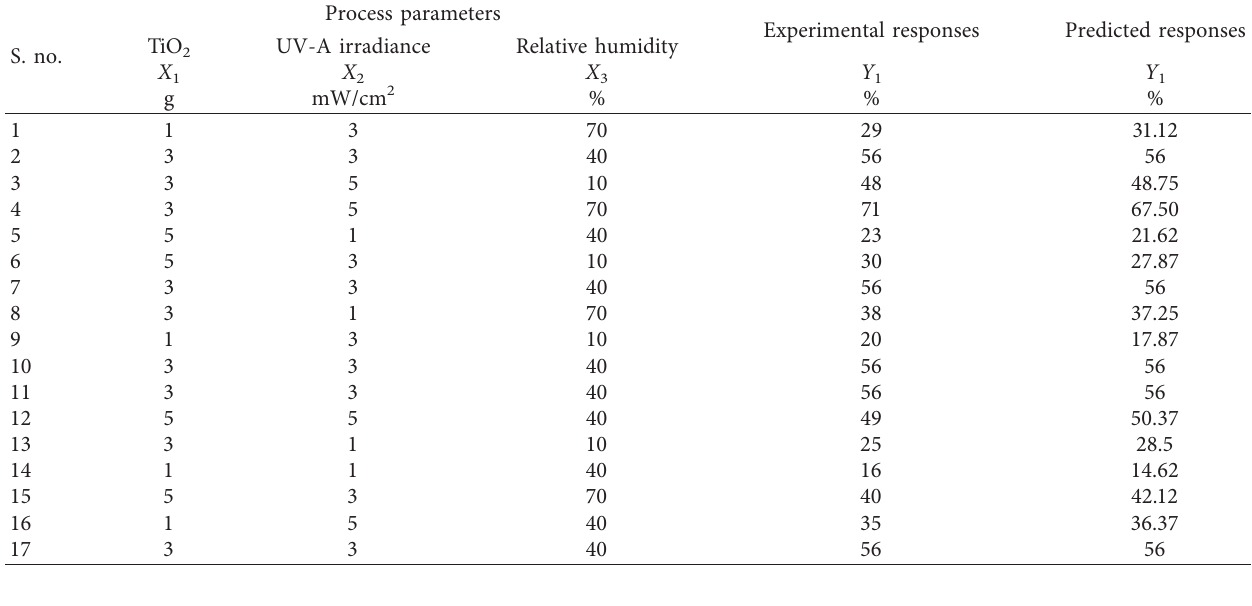
Table 2: Comparison of experimental and predicted responses.